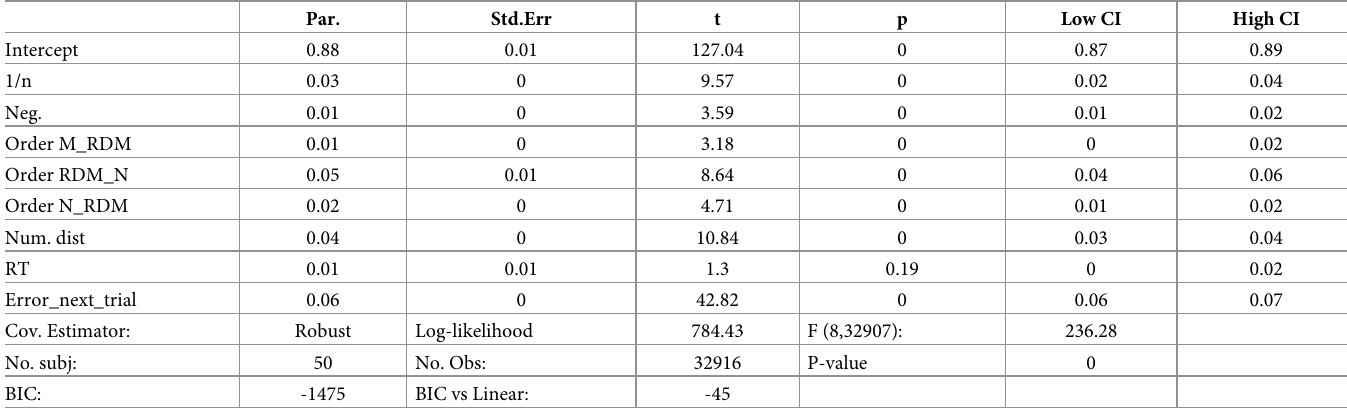
Table 1.1. Accuracy. Exp. 1.1 Random Effects Estimation. Par.